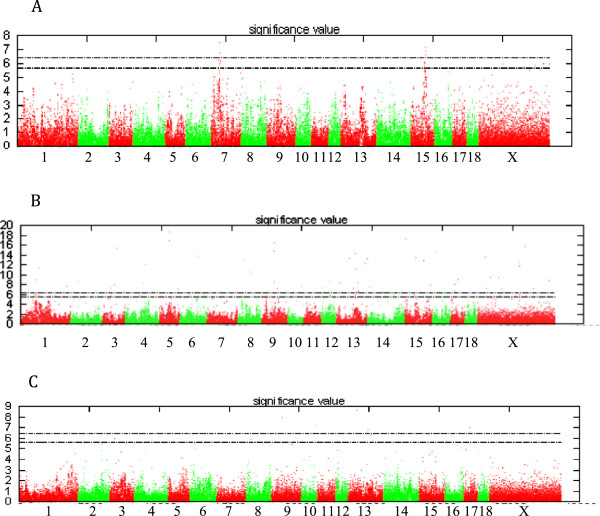
Graphical interpretation of SLLW (A), Duroc (B) and Titan (C) SNP results for Rib Fat for all chromosomes. Legend: Graphical interpretation of SNP results for Rib Fat for all chromosomes. Red dots represent SNPs on odd numbered chromosomes while the green dots are from even numbered chromosomes. The dotted lines represent the 5% (bottom line) and 1% (top line) confidence thresholds.